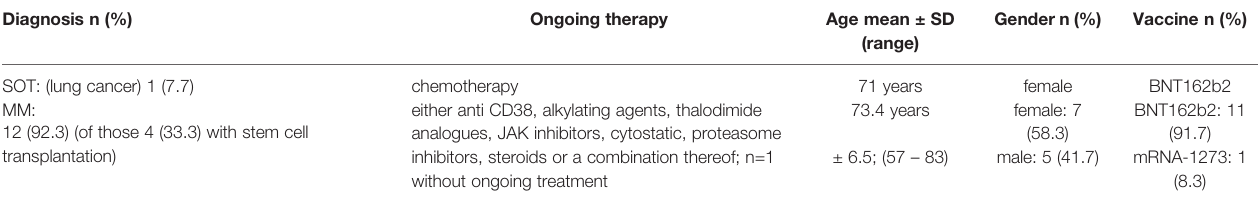
TABLE 3 | Characteristics of non-responders at four weeks after the second